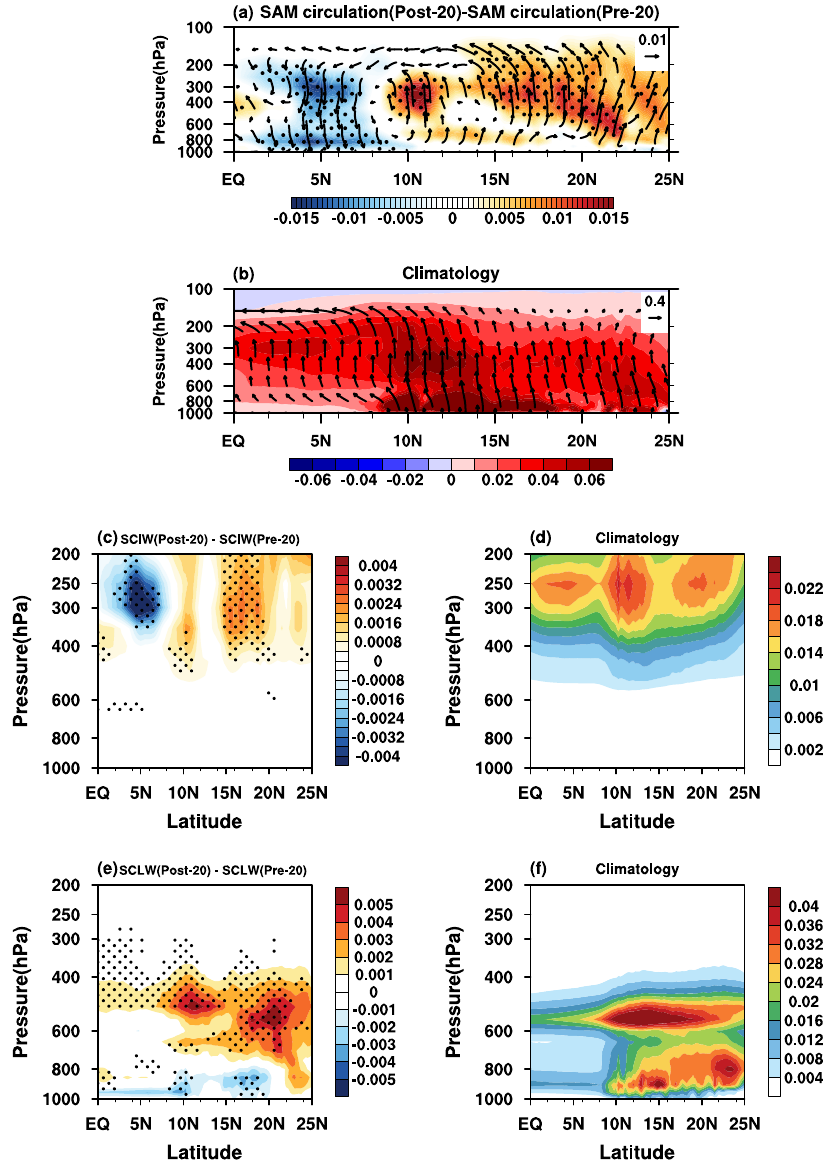
Fig. 4 Changes in SAM circulation and cloud structure. a Composite of anomalous negative Omega (shaded) and meridional-vertical wind vectors (units of ms − 1 for v and − 100 Pa s − 1 for Omega) overlaid with stippling, indicating areas that are statistically signi fi cant at a 99% con fi dence level. b Climatology of negative Omega (shaded) and meridional vertical wind vectors. All variables are averaged over 73 – 77 °E. Composite of meridional vertical structures of anomalous ( c ) SCIW(unit:gkg − 1 ) ( e ) SCLW(unit:gkg − 1 ) overlaid with stippling indicating statistically signi fi cance at a 99% con fi dence level. Climatology of ( d ) SCIW and ( f ) SCLW. SCIW and SCLW are averaged over 73 – 77 °E in